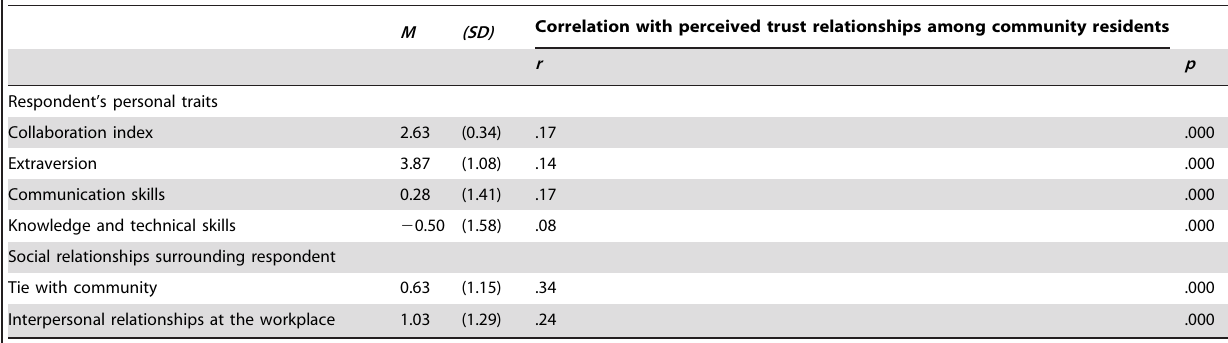
Table 6. Collaboration index, extraversion, communication skills, knowledge and technical skills, tie with community, and interpersonal relationships at the workplace (means, standard deviations, and Pearson’s r coefficients with perceived trust relationships among community